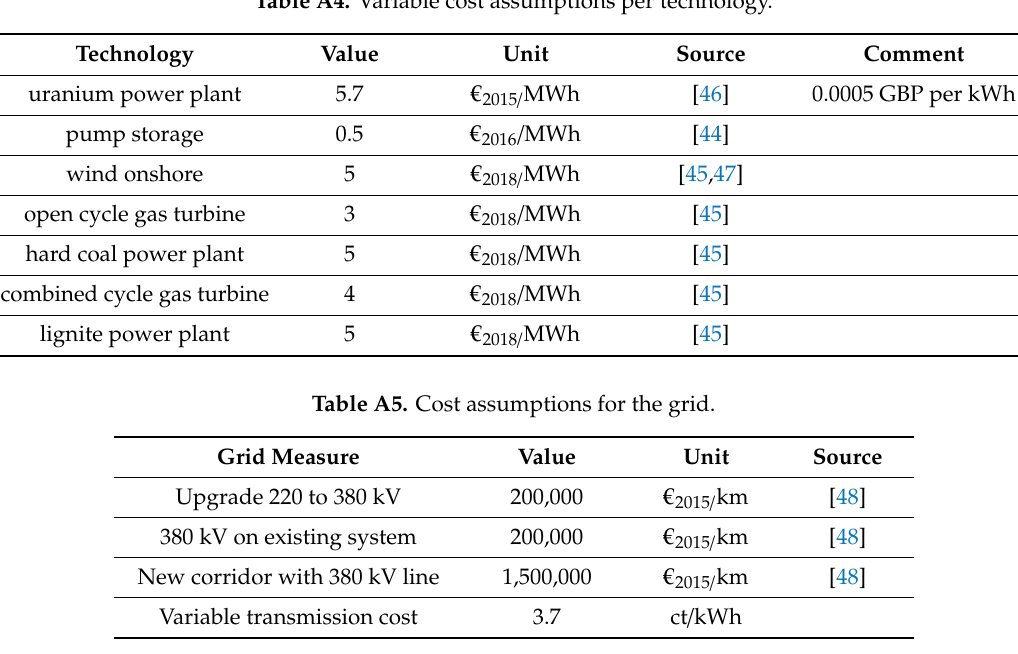
Table A4. Variable cost assumptions per technology.